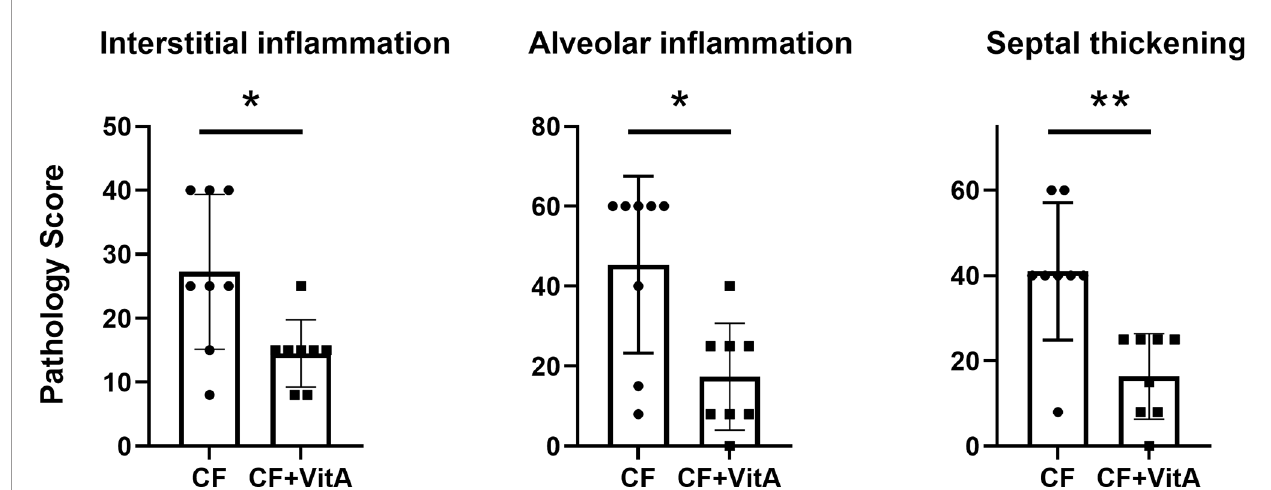
FIGURE 1 | Vitamin A supplements at the time ofparain fl uenza virusinfectionsreduce lunglesionsscored 5-6 weeks post-infection.Data are fromone of three experiments demonstrating the reduction oflunglesionsin CF mice supplementedwith vitamin A at the time of a virusinfection. Lesions were given relative scores. Each symbol represents a different test mouse (no lesionswere observed in control,uninfectedmice).In each of the three experiments, the vitamin A-supplemented mice (CF +VitA) exhibited signi fi cantly or marginally reduced scores for interstitial in fl ammation,alveolar in fl ammation,and septal thickeningat weeks5-6 post-virus infection compared to mice that received no supplement (CF). Meanswith standard deviationsare shown. Mann Whitney tests were performed to compare groups (*p < .05, **p <